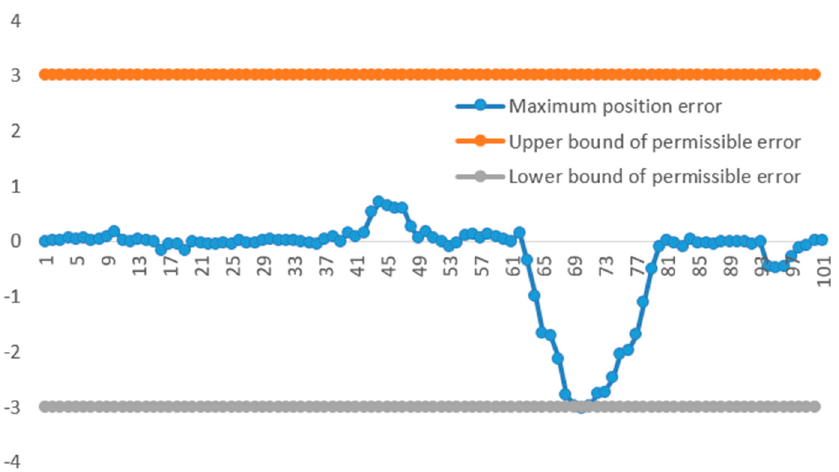
Figure 15. Position error of each trajectory point in the x-direction.